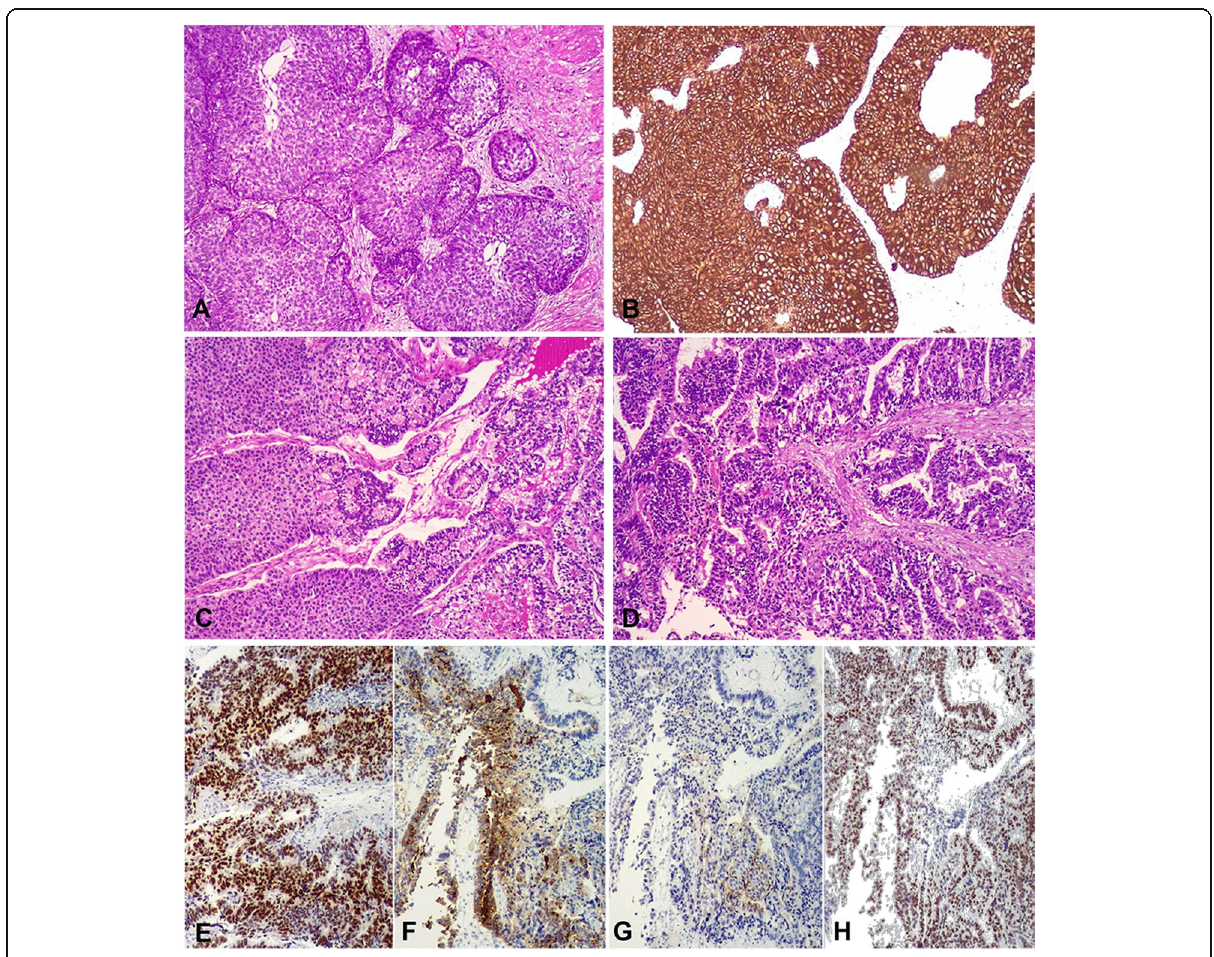
Fig. 1 Surgical specimen of previous nephroureterectomy exhibiting a high grade urothelial carcinoma with conventional pattern (HE) ( a ) positive for CK7 ( b ). Interphase between conventional urothelial carcinoma and glandular pattern (HE) (c) . Areas with glandular pattern (HE) ( d ). CDX2 ( e ). AFP ( f ). GLP3 ( g ). SALL4 ( h ) in areas with glandular